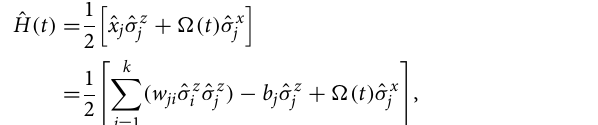
k z x j b j , where the activation 1 w ji ˆ σ i − i ˆ = = t f in the = (cid:31)